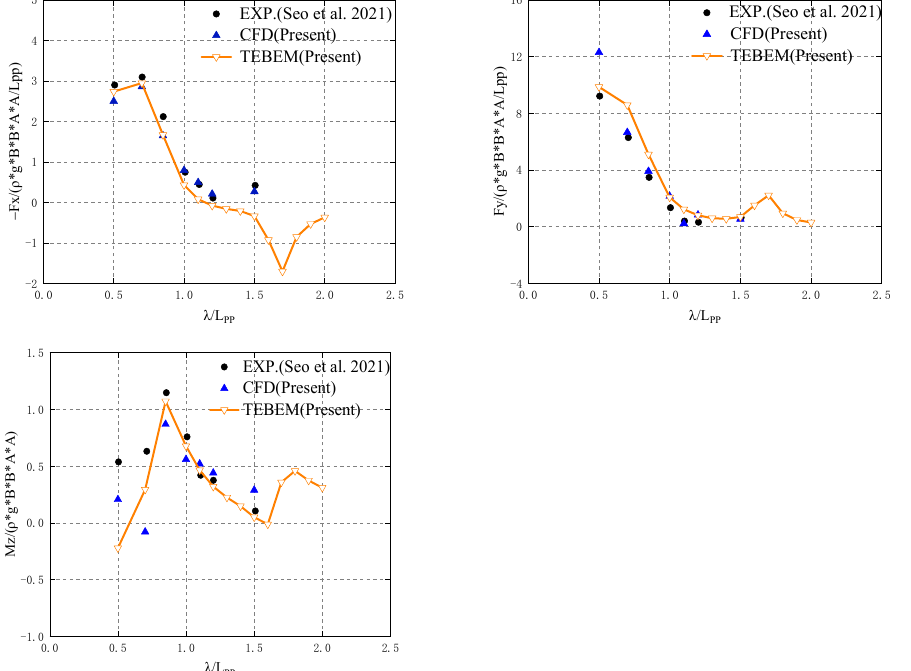
Figure 15. The surge, sway, and yaw wave drift forces and moment of KVLCC2 under H = 0.02 L PP , χ = 120°, β = 0°, and U = 6.0 kn.